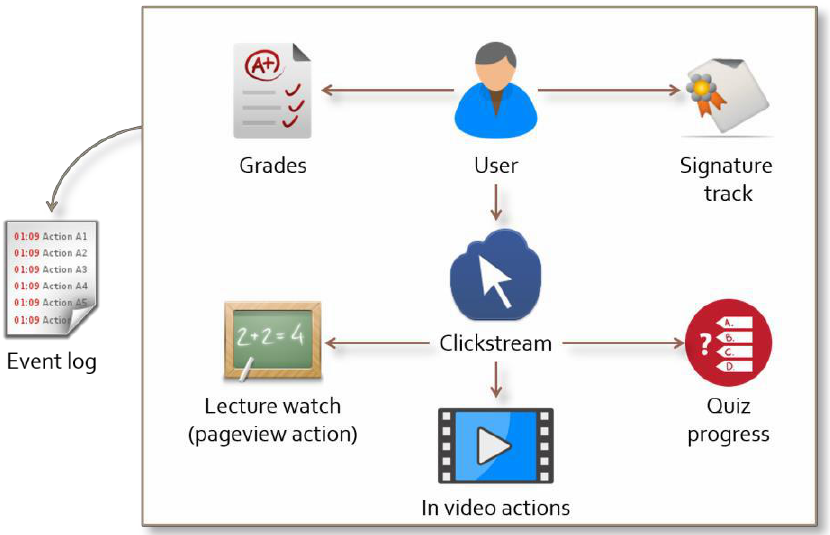
Figure 1. Generalized overview of Coursera data